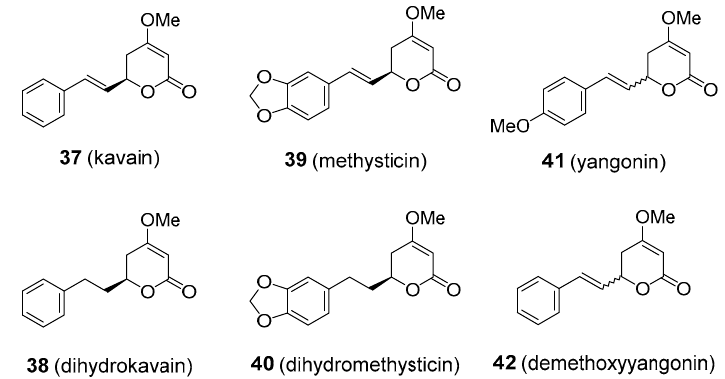
Figure 10. Molecular structures of kavalactones.